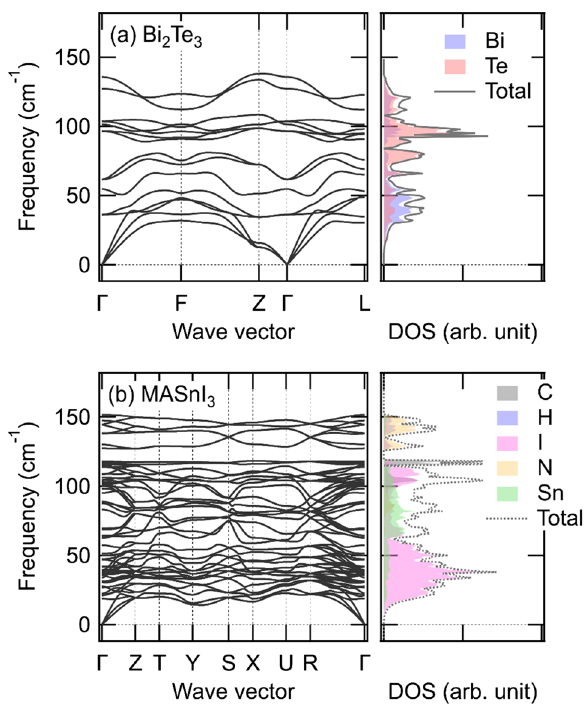
Figure 7. Phonon dispersions and atomic projected phonon DOS of (a) Bi 2 Te 3 and (b) MASnI 3 .